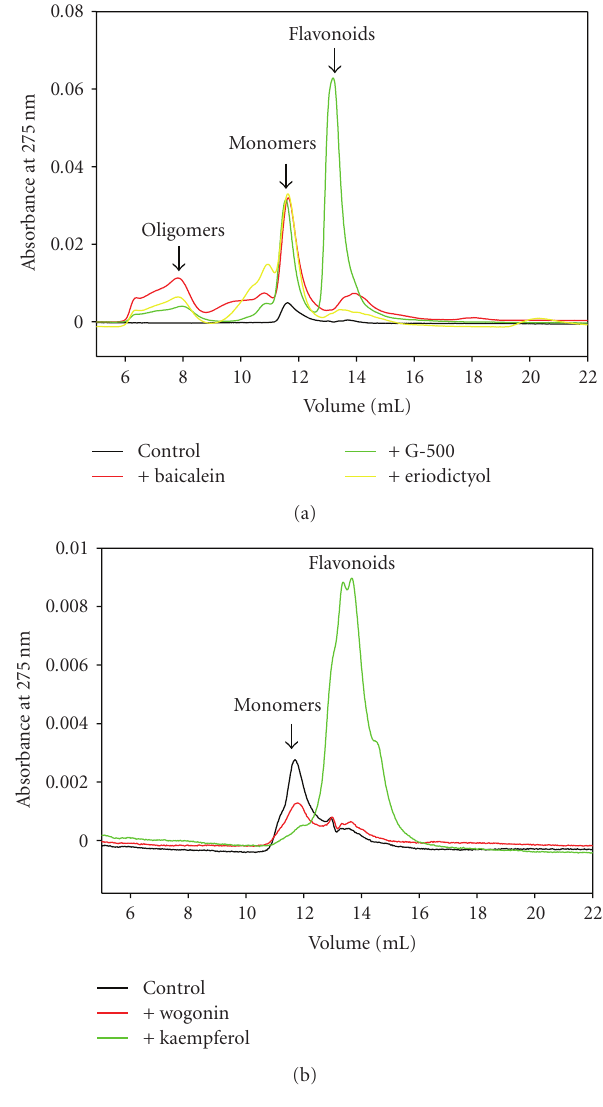
Figure 8: SEC-HPLC profiles of the supernatants of α -synuclein samples incubated in the absence and presence of various flavonoids: inhibitory flavonoids (a) and non-inhibitory flavonoids (b).